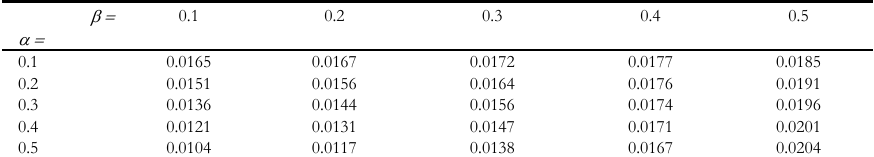
Variance of MTSP for κ = 4 , θ =